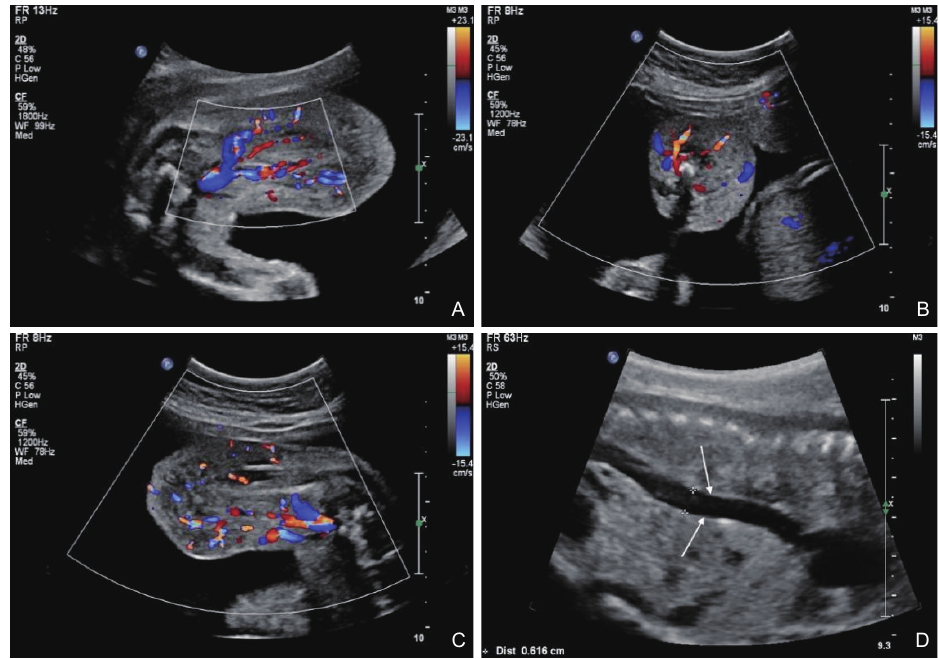
Figure 2 Color Doppler imaging of the lesion in Coronal view (A) and transverse view (B) showed femoral artery and vein with tortuous course. (C) Spotty blood flow signals were detected within the thickened subcutaneous tissues in the right thigh. (D) The dilated inferior vena cava (white arrows) was seen on gray scale ultrasound